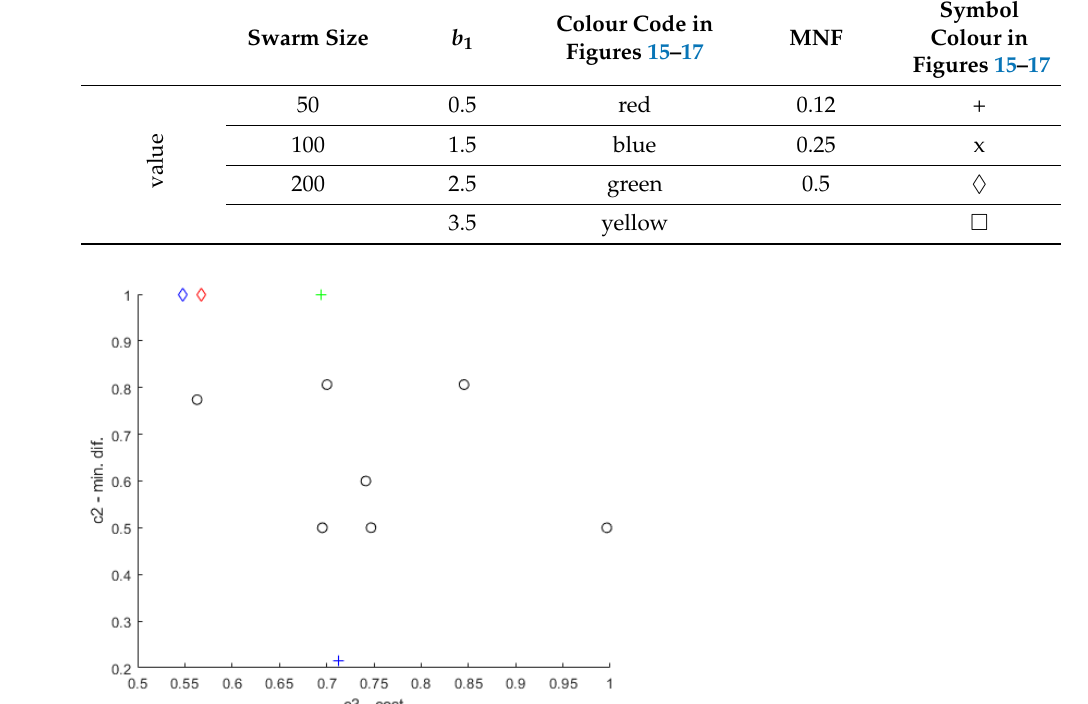
Figure 15. Particle Swarm Optimization. Swarm size: 50. Black ball—LHS. Others, see Table